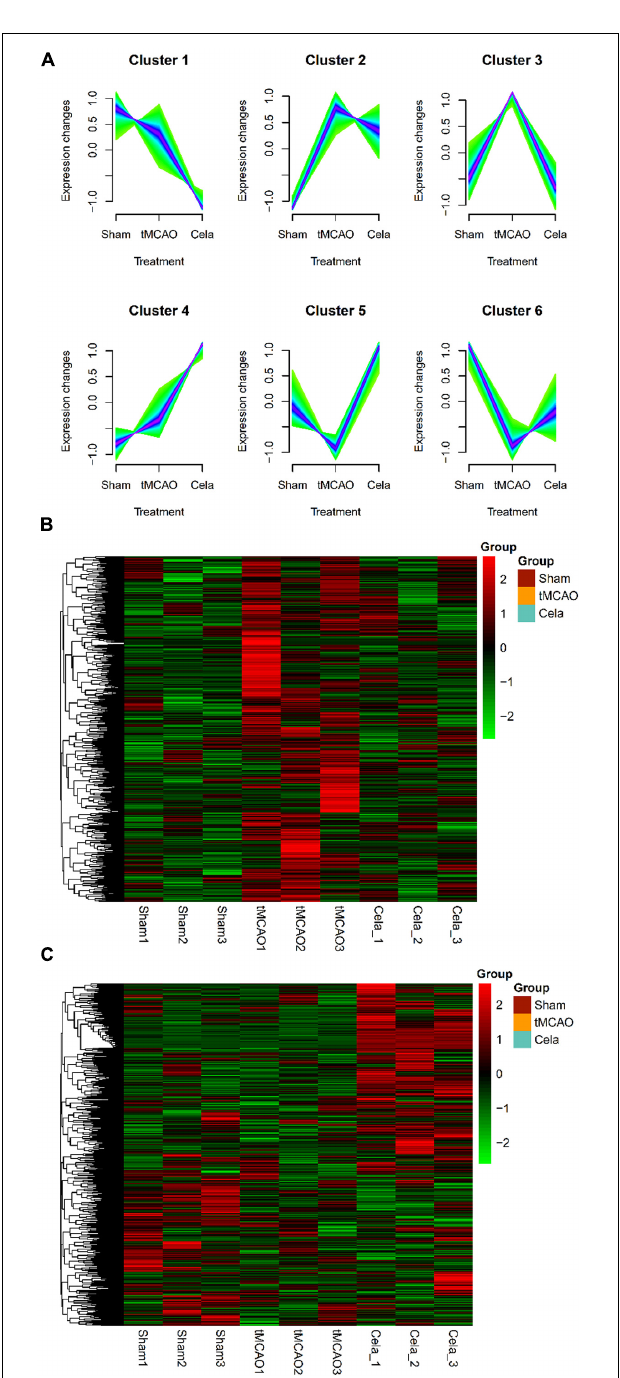
FIGURE 4 | (A) Six clusters of lncRNAs among the three groups by Mfuzz analysis. (B) The heatmap of down-regulated genes in lncRNA cluster 3. (C) The heatmap of up-regulated genes in lncRNA cluster 5 and